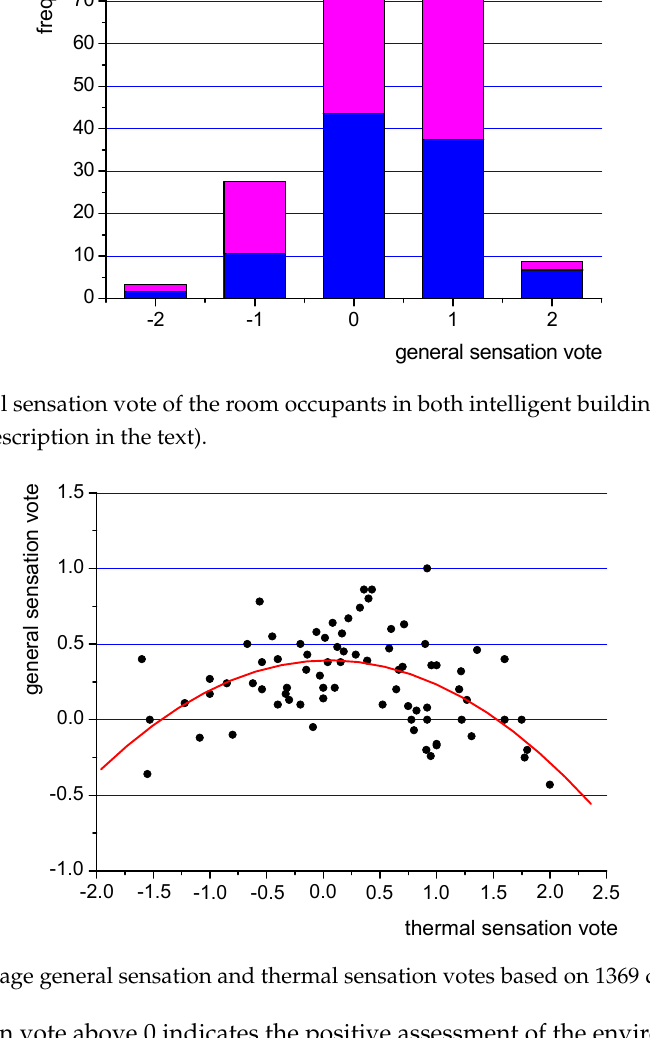
Figure 18. General sensation vote of the room occupants in both intelligent buildings based on 1369 questionnaires (description in the text).